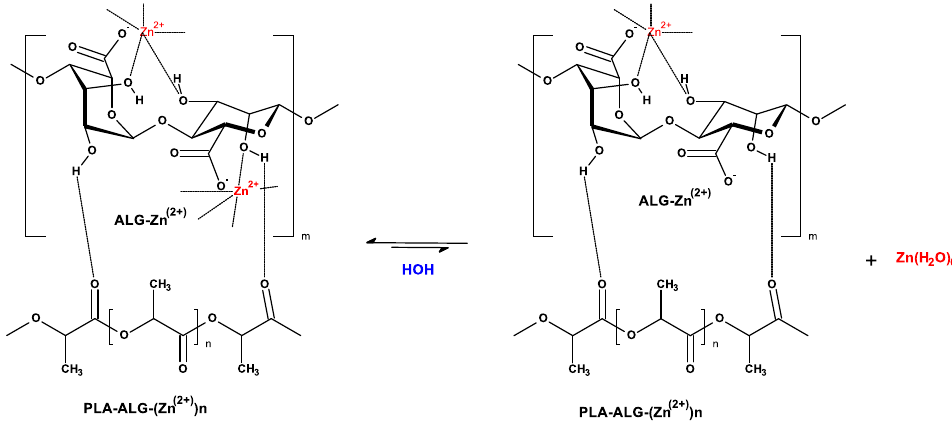
Figure 2. The reactions involved in the release of zinc ion from the PLA-ALG-Zn (2+) composite in an aqueous environment.